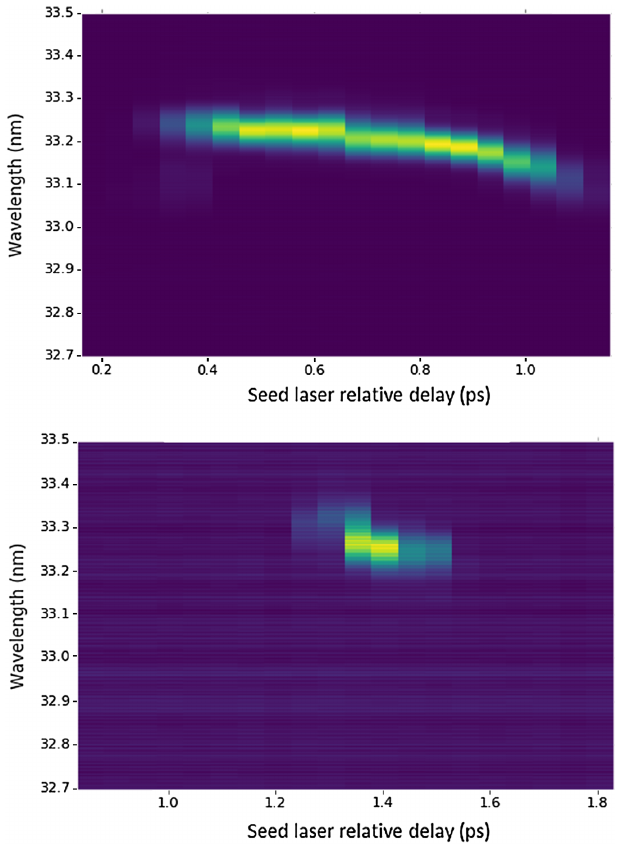
FIG. 5. Spectrum of the first stage of FERMI HGHG FEL2 vs seed laser delay. The seed laser is superimposed to the whole electron beam (top) and to a single beamlet produced with scraping in BC1 (bottom). The spectrum intensity is normalized in both plots to the peak value. The seed is time shifted in steps of 50 fs; 20 shots are consecutively recorded for each delay value